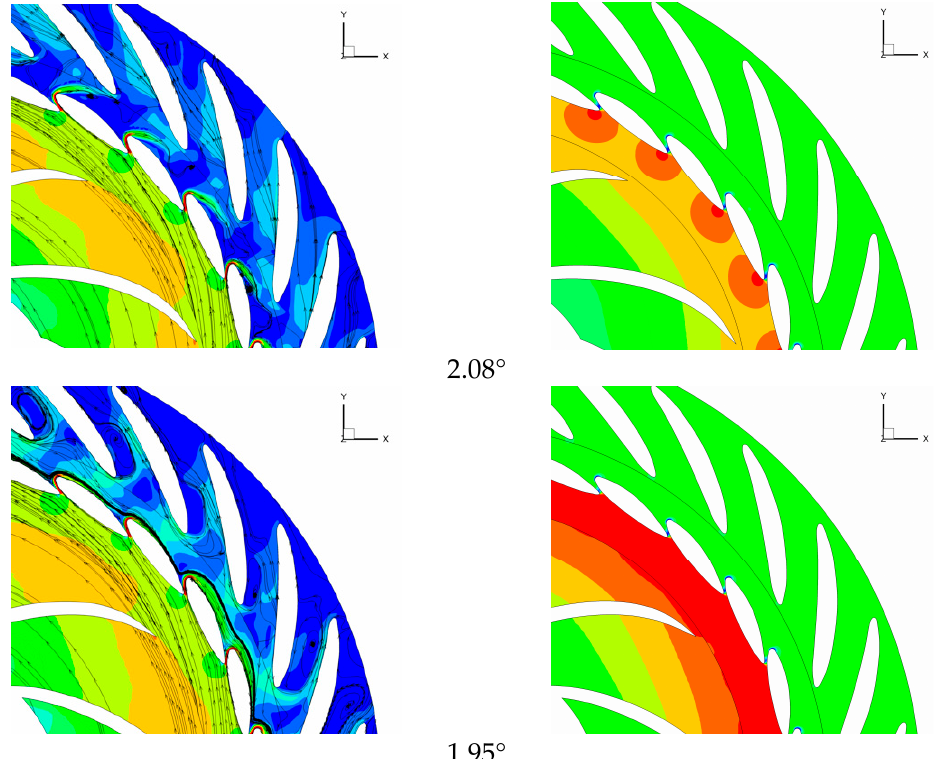
Figure 11. Local velocity contours ( left ) and pressure contours ( right ) of the shutdown process (Z = 0 plane, GVO = 6.5°~1.95°).